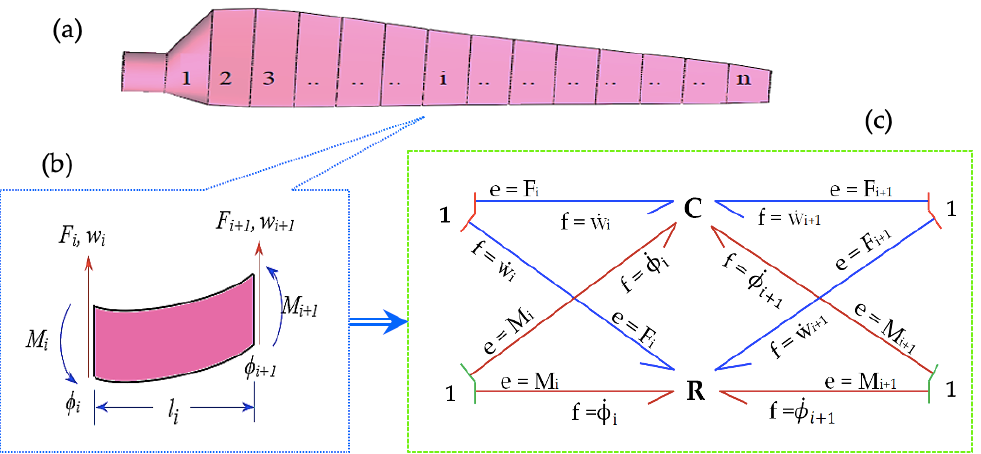
Figure 2. ( a ) n blade sections; ( b ) loads applied on i th element; ( c ) C- and R-field bond graph of i th element.